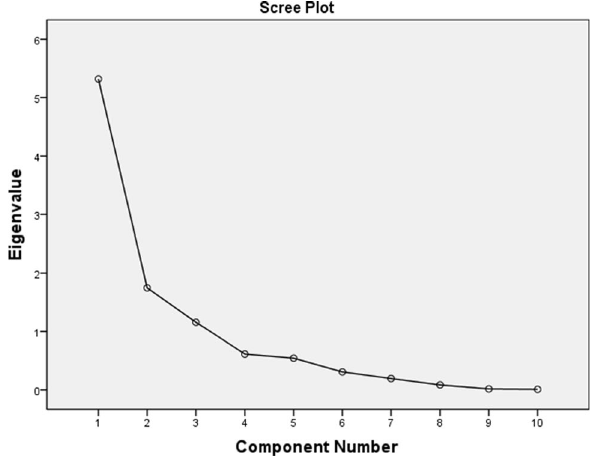
Fig. 9 Scree plot of the eigenvalues